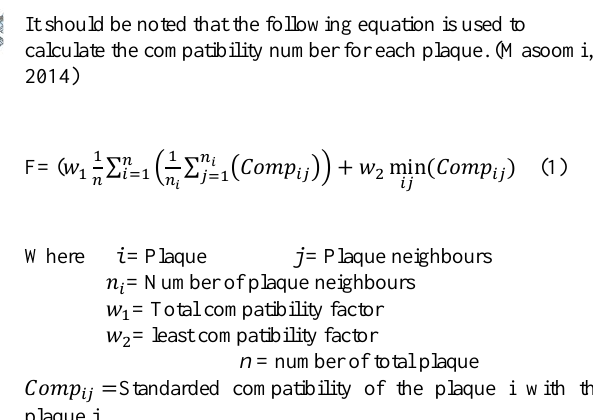
Table 2. The AHP standardized